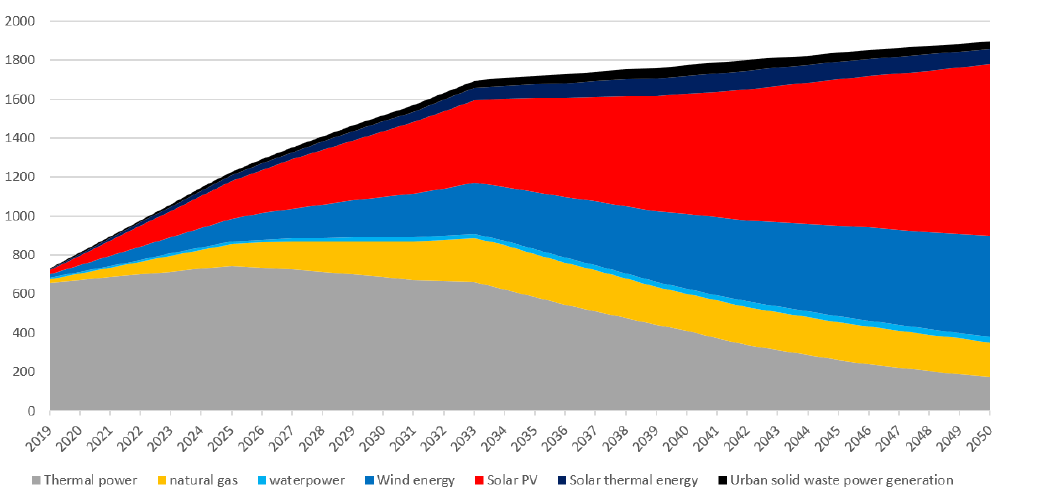
Figure 17. Comparison of carbon dioxide emissions in Inner Mongolia under three scenarios.